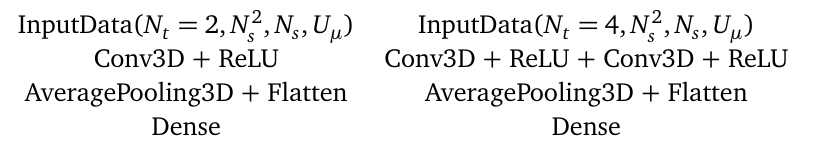
Table 1: Neural network architectures for various size of input configurations.